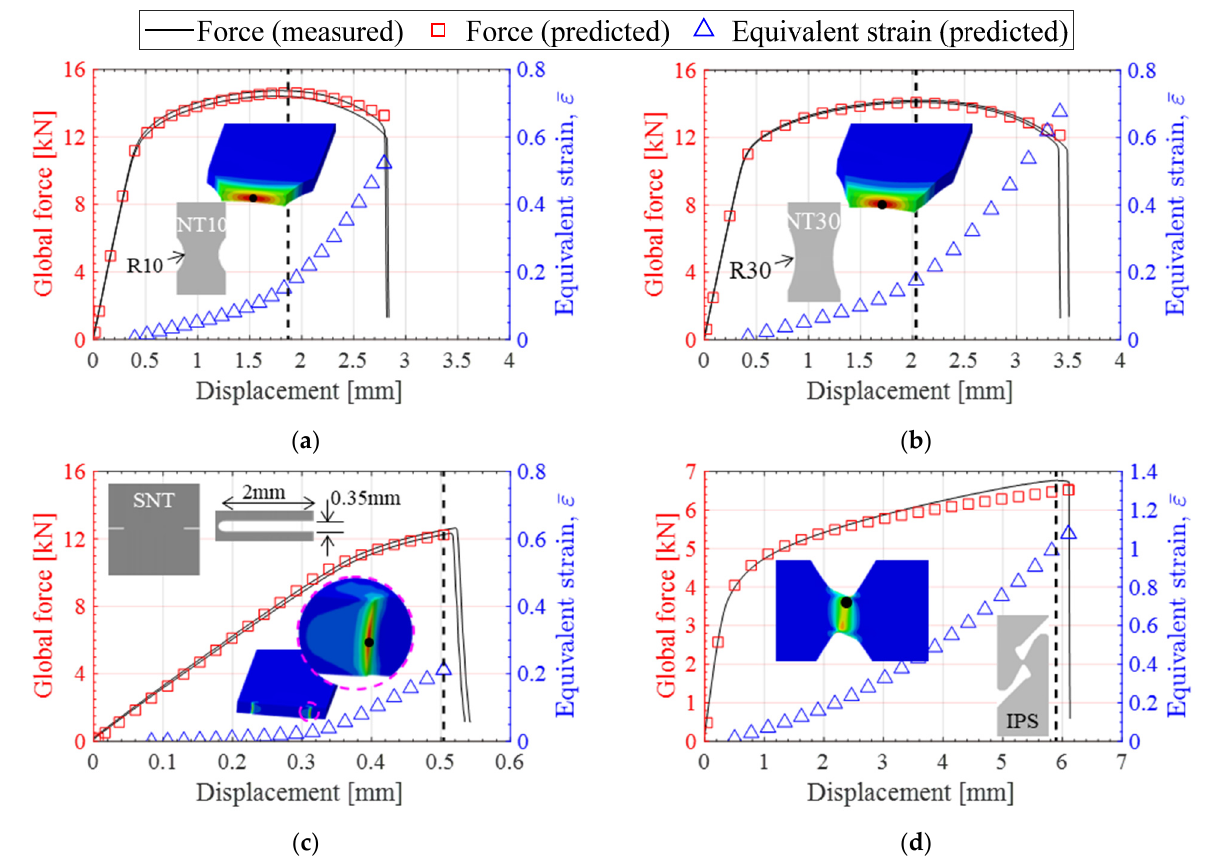
Figure 7. Global forces measured from the fracture tests and corresponding FE simulation of the fracture tests are compared for different types of specimens. Equivalent strain history is also computed as a function of displacement. ( a ) NT10 (notched tension with R10); ( b ) NT30 (notched tension with R30); ( c ) SNT (Sharp notched); ( d ) IPS (In-Plane Shear).